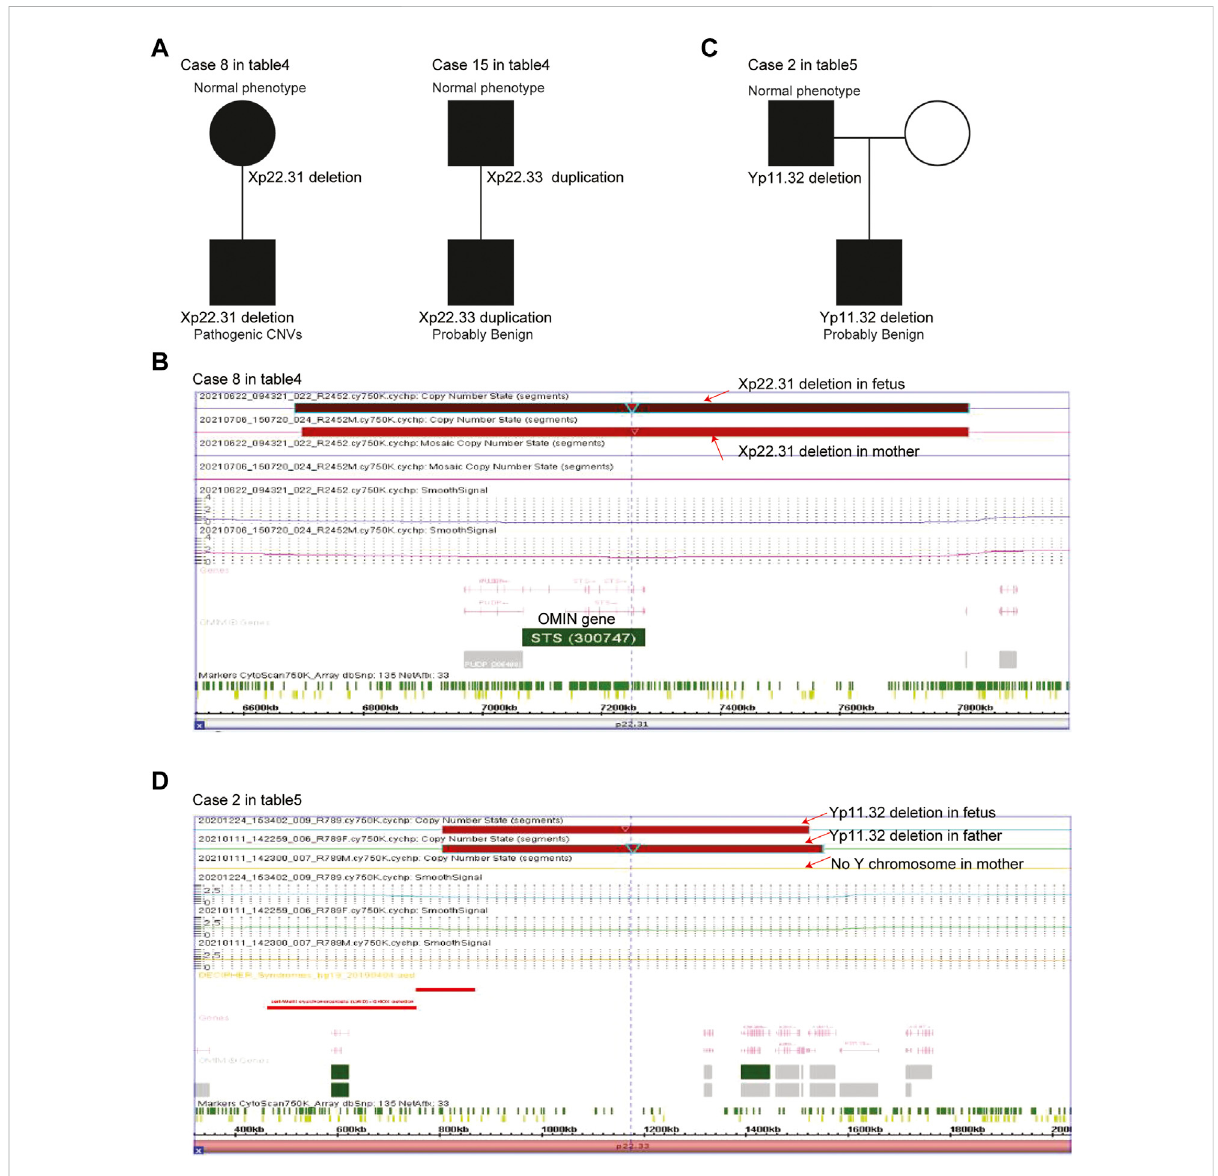
FIGURE 3 Parent-of-origins of the sex chromosomal deletions/duplications in male fetuses. (A) Pedigree of case 8 and case 15 female fetuses with X chromosomal deletions/duplications. (B) Xp22.31 deletions in the case 8 male fetus and his mother. (C) Pedigree of the case 1 female fetus with X chromosomal deletions/duplications. (D) Yp11.32 deletions in the case 1 male fetus and his